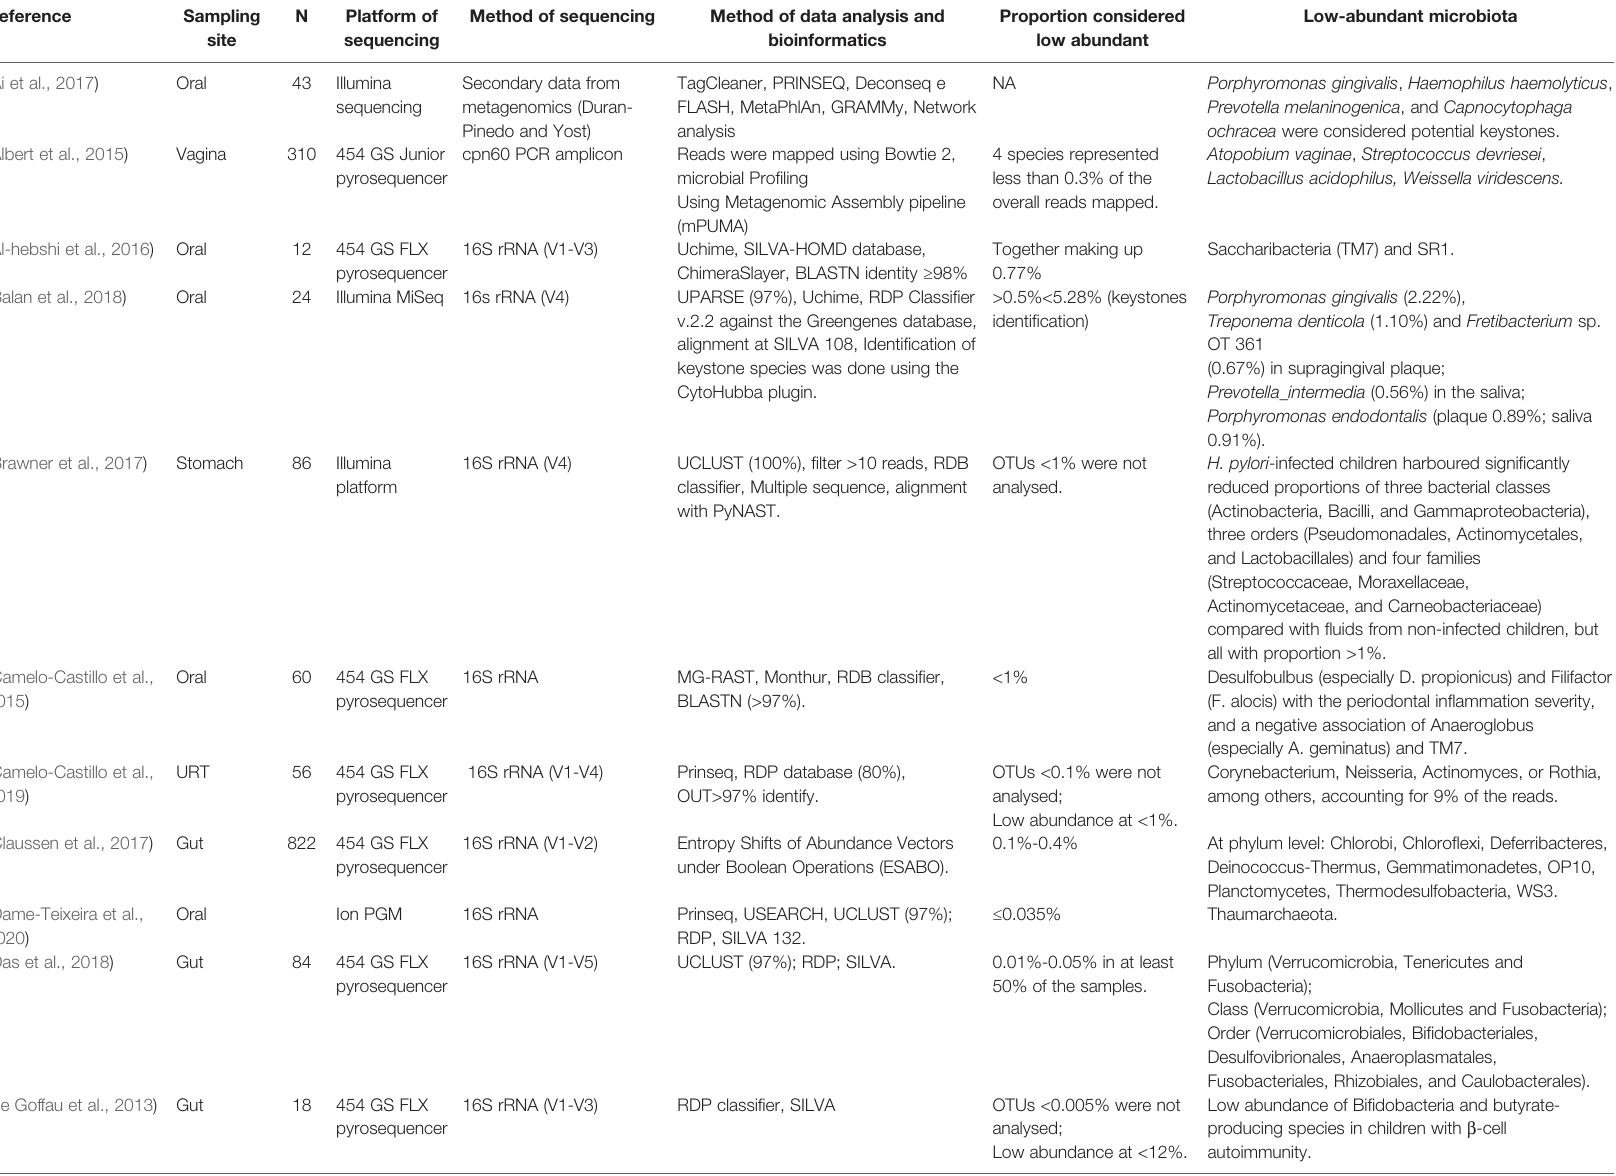
TABLE 1 | Qualitative Data Synthesis of the Included Studies (n =